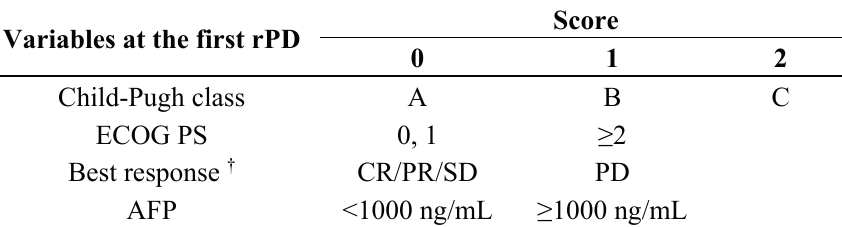
Table 3. Scoring system for PPS.